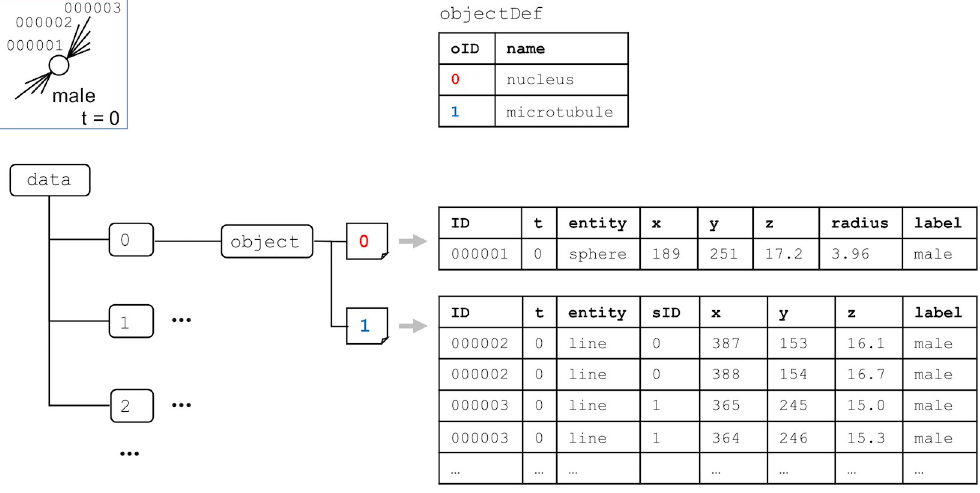
Fig 4. An example of the description of the spatiotemporal information of multiple biological objects (a nucleus and microtubules). The object group has two different datasets numbered 0 and 1 corresponding to the reference numbers of biological objects predefined in the objectDef